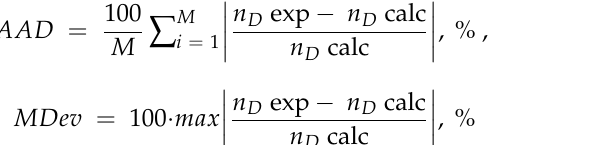
11 of 19 Table 3. Comparison of experimental refractive indices 𝑛 𝐷 of pure water with literature values. Experiment